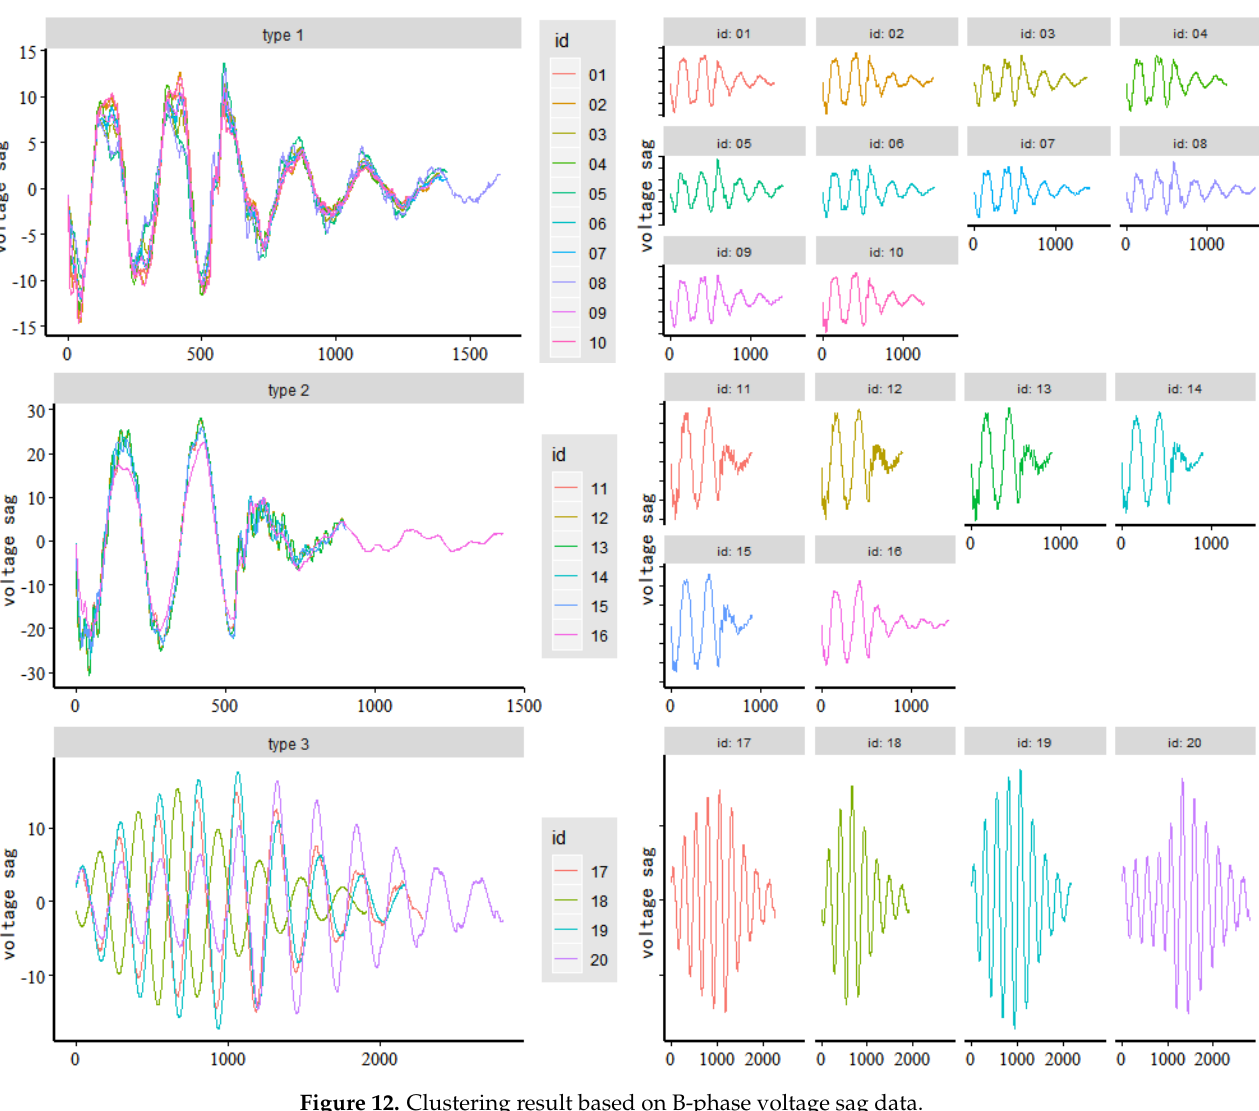
Figure 12. Clustering result based on B-phase voltage sag data.